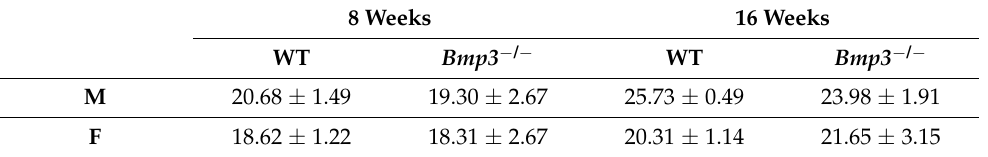
Table 1. Total body mass (in g) of young and adult Bmp3 − / − and WT mice in males (M) and females (F). Data are represented as the mean ± standard